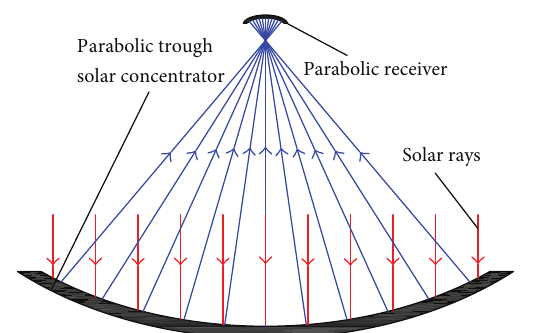
Figure 14: The parabola absorber is adopted on parabolic trough solar concentrator.